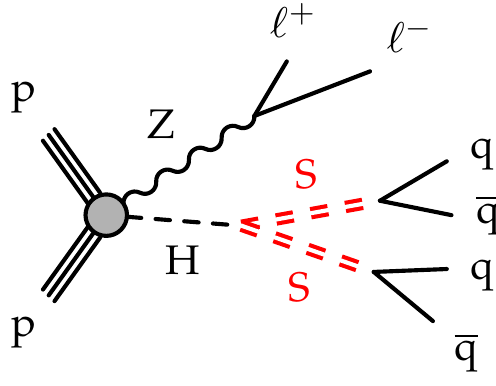
Figure 1 . Feynman diagram of a simplified model for the Higgs boson decaying to a pair of long- lived scalar particles ( S ). The Higgs boson is produced in association with a Z boson, where the